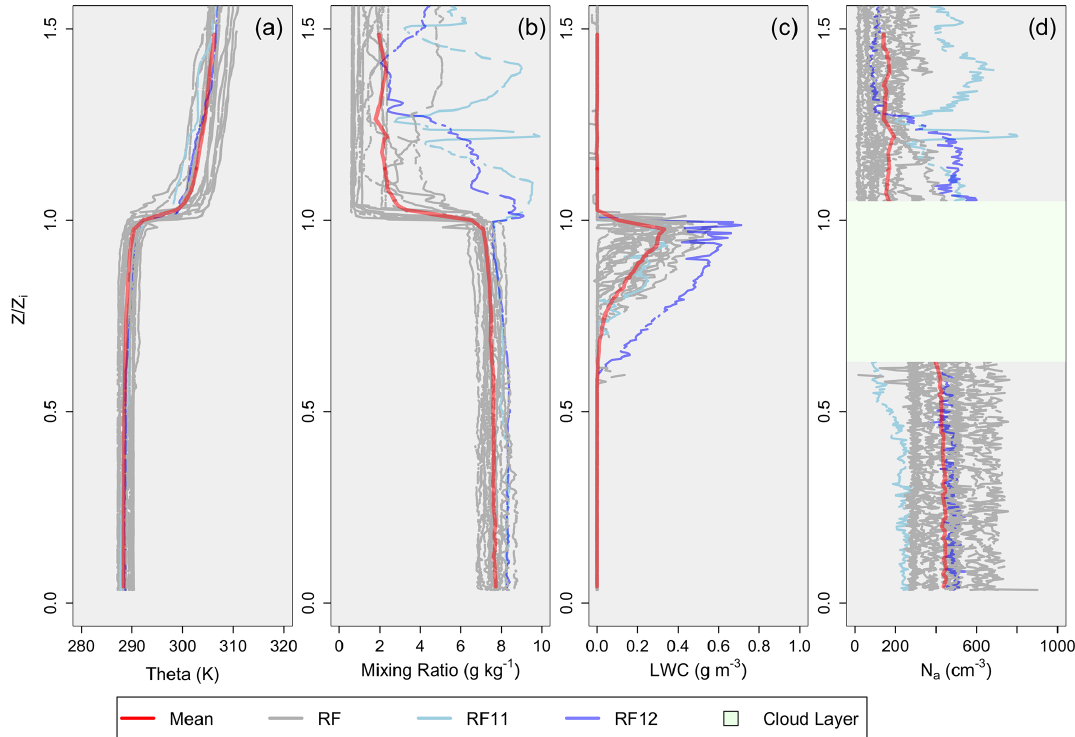
Figure 5. Profiles scaled by z i . (a) θ (K); (b) q (gkg − 1 ); (c) LWC (gm − 3 ); (d) N d (cm − 3 ). The red profile represents the mean value, and the two blue profiles represent RF11 (light blue) and RF12 (dark blue). The green layer represents the relative cloud layer for (d) , as aerosol data cannot be collected in the cloud